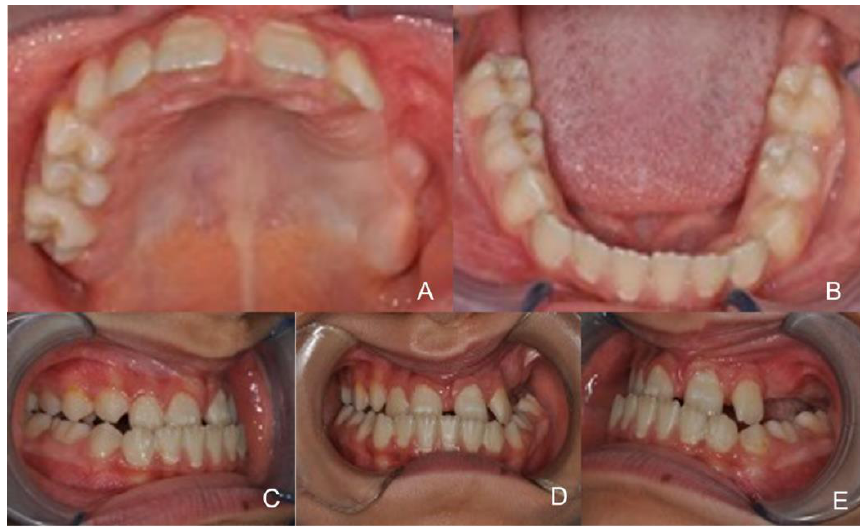
Figure 1. Intraoral view. ( A ): Maxillary occlusal view; ( B ): mandibular occlusal view; ( C ): Right molar relationship; ( D ): frontal view; ( E ): left molar relationship.